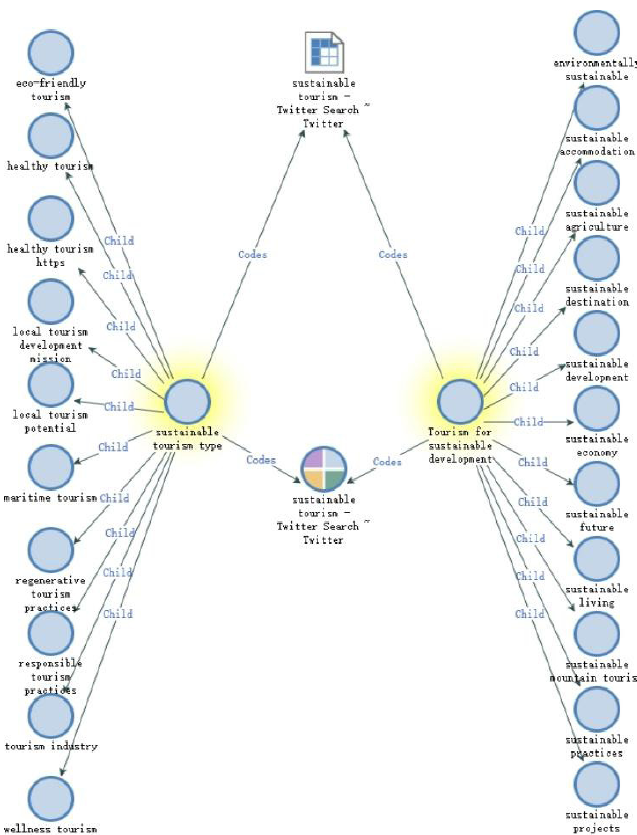
Figure 4. Comparative analysis map of the relationship between the sustainable tourism type and tourism for sustainable development